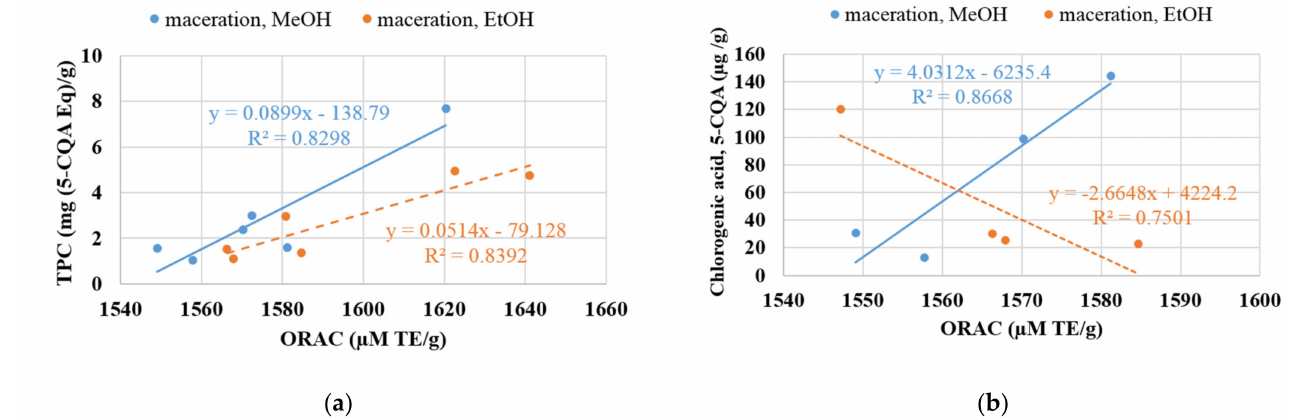
Figure 5. Correlation between total ORAC values and TPC contents ( a ) and chlorogenic acid ( b ) under maceration extraction with two